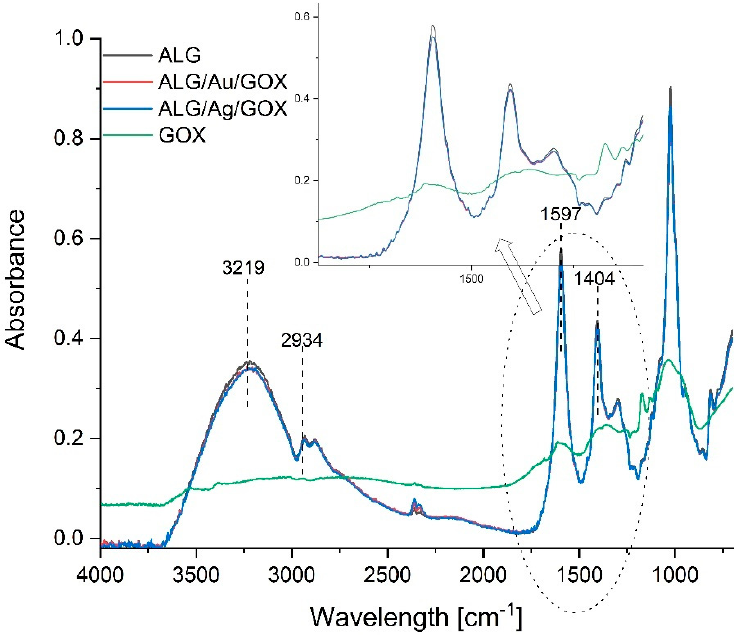
Figure 5. FTIR spectra of ALG (black line), ALG/Au/GOX (red line), ALG/Ag/GOX (blue line) and GOX (green line).